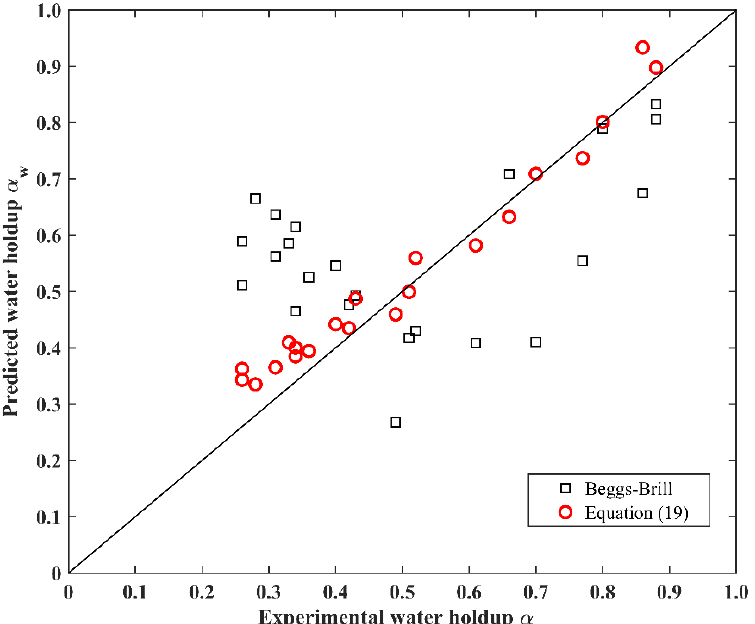
Figure 13. Comparison of different models predicting water holdup with the experimental data for the gas – water two-phase flow. The input water cut ε w is equal to 100%. The red circles corresponded to Equation (19), the black squares corresponded to the Beggs-Brill empirical model [31].